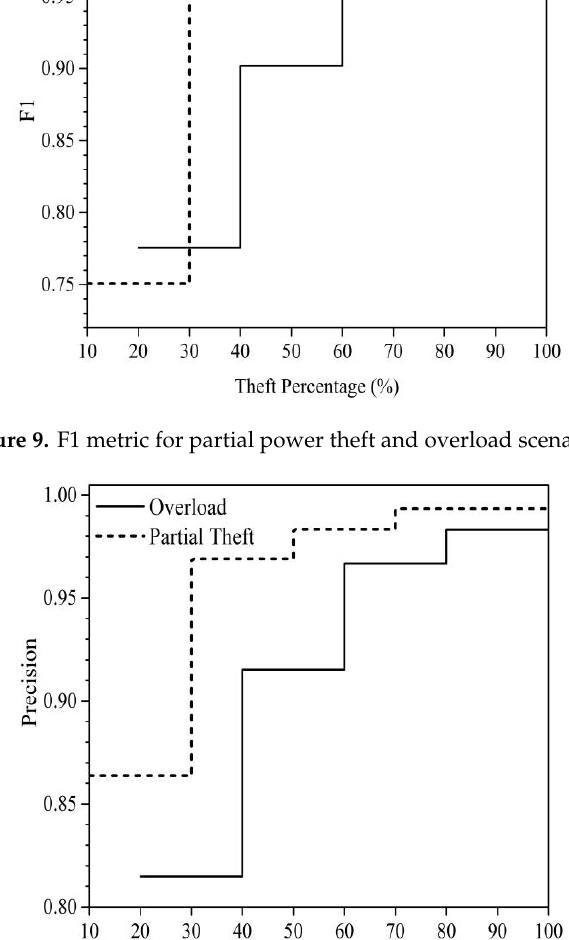
Figure 10. Precision metric for partial power theft and overload scenarios.